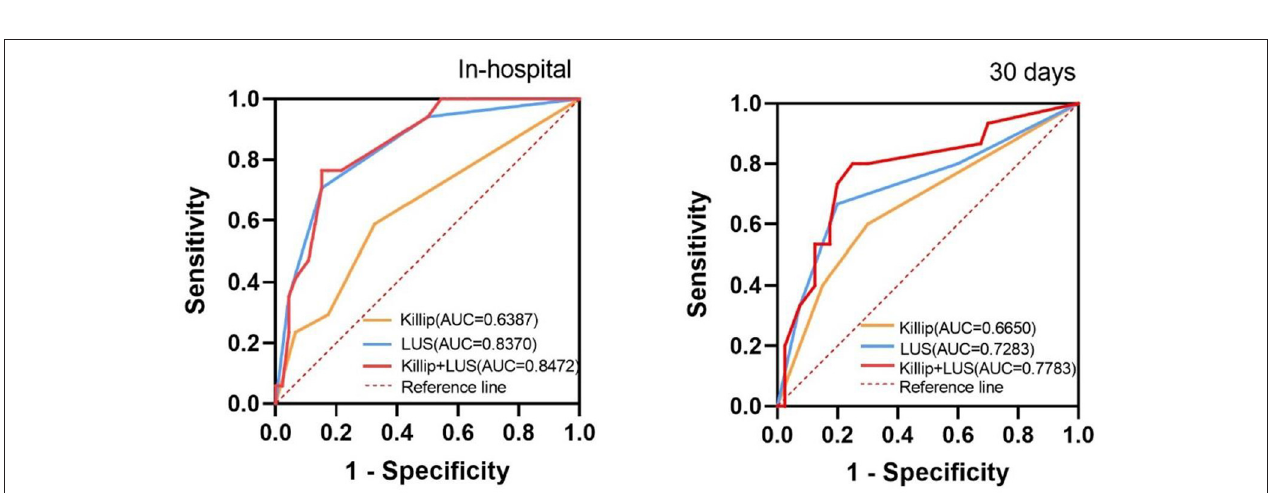
FIGURE 3 | Receiver operating characteristic curves for “Killip”, “LUS”, and “Killip + LUS” classification to predict the in-hospital and 30 days composite outcome. AUC, the area under the curve. In-hospital, during the hospitalization; 30 days, during 30 days follow-up; Killip, Killip classification; LUS, LUS classification; Killip + LUS, the combination of LUS and Killip